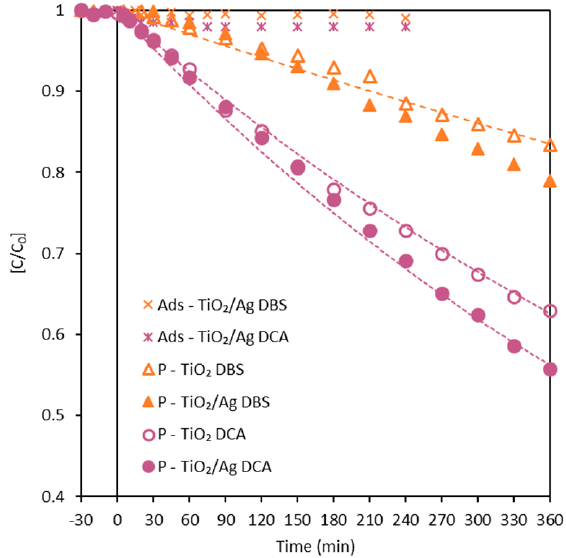
Figure 5. Photocatalytic degradation data of DBS and DCA with TiO 2 and TiO 2 /Ag submerged membranes without permeation. Dotted lines represent the fitted curves to pseudo-first-order kinetic model. P: photocatalytic experiments.